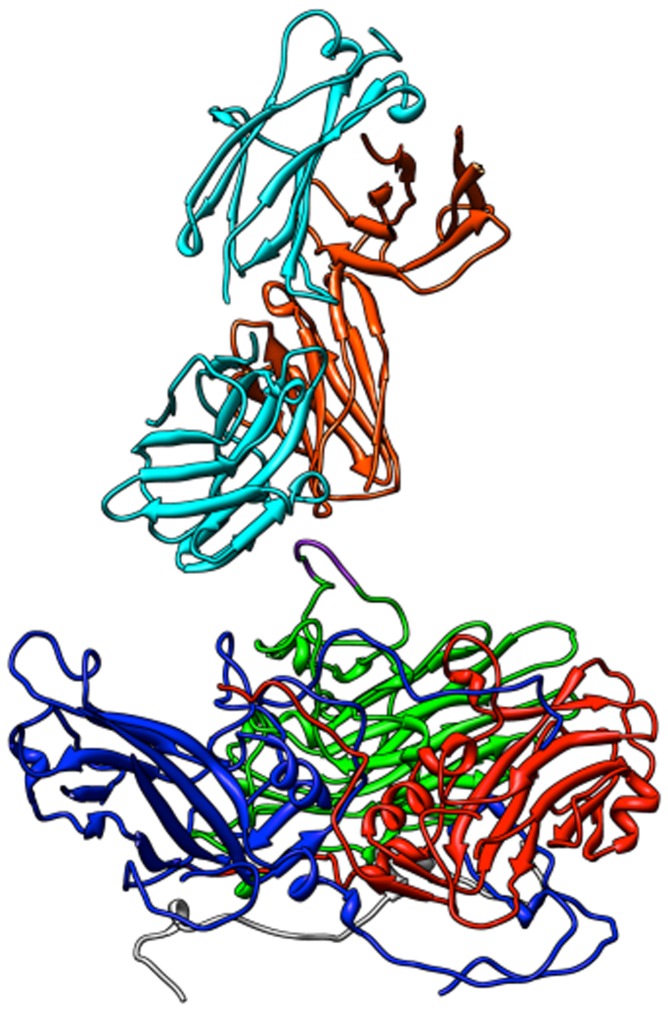
The ELDKWA epitope of chimeric virus B1-16 (shown in purple) docked with the surface of the 2F5 paratope.The protomeric unit of HRV, 60 of which come together to make the viral capsid, is in the bottom of the image and one of the Fv domains of the 2F5 antibody is in the top. The viral proteins are colored blue for VP1, green for VP2, and red for VP3, and the heavy and light chains of 2F5 are respectively in orange and light blue.